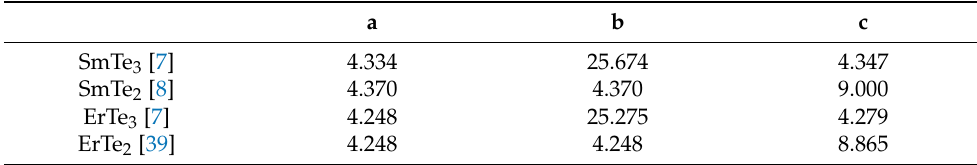
Table 1. The lattice constants (Å) of RTe 3 and RTe 2 (R = Sm,